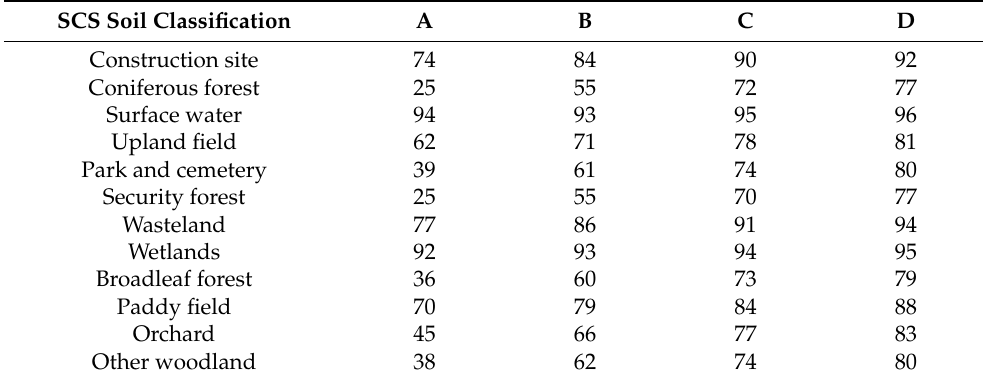
Table 3. CN values corresponding to various land use and soil hydrological